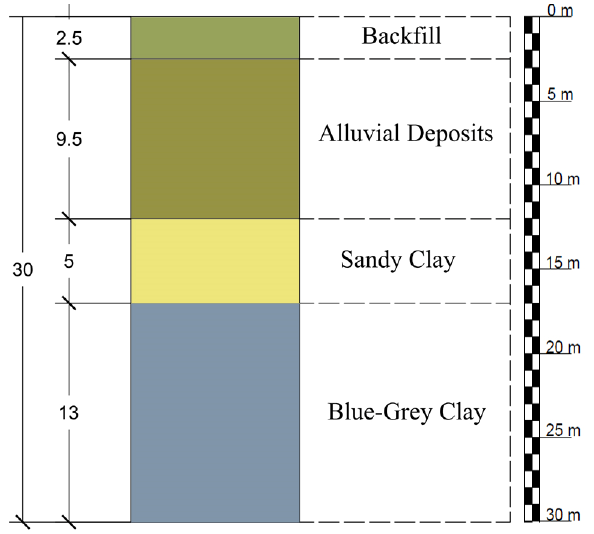
Figure 14. Soil stratigraphy obtained by in situ characterization.